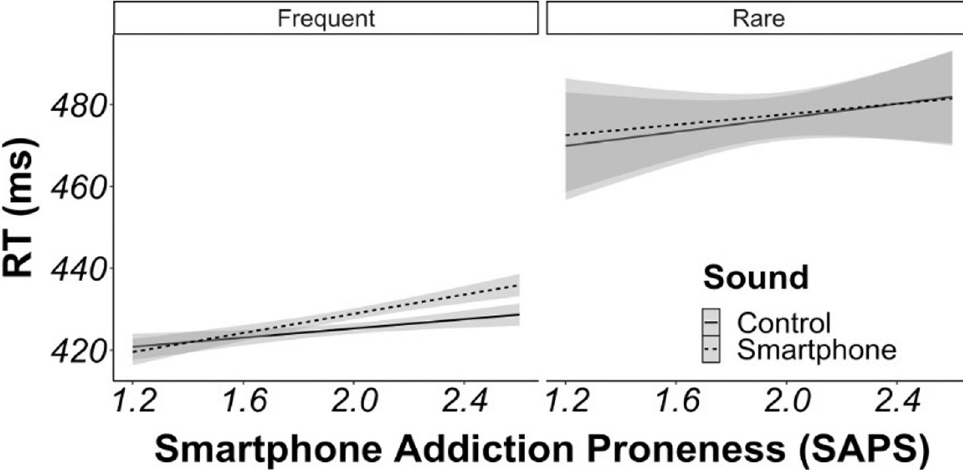
Fig 3. Interaction analysis for reaction times predicted by sound condition and smartphone addiction. Plot of reaction times on trials with smartphone sounds (dashed line) vs. control sounds (solid line) as a function of individual differences in the proneness to smartphone addiction. Plotted separately for frequent and rare target